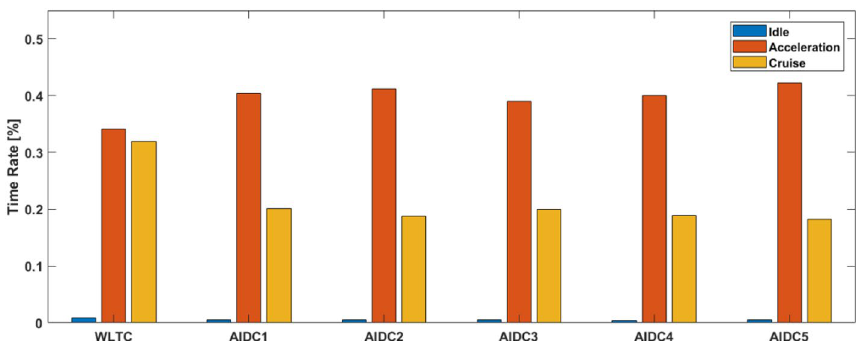
Fig. 10 Distributions of the idling (zero vehicle speed), acceleration and cruise driving time rates of the cycles